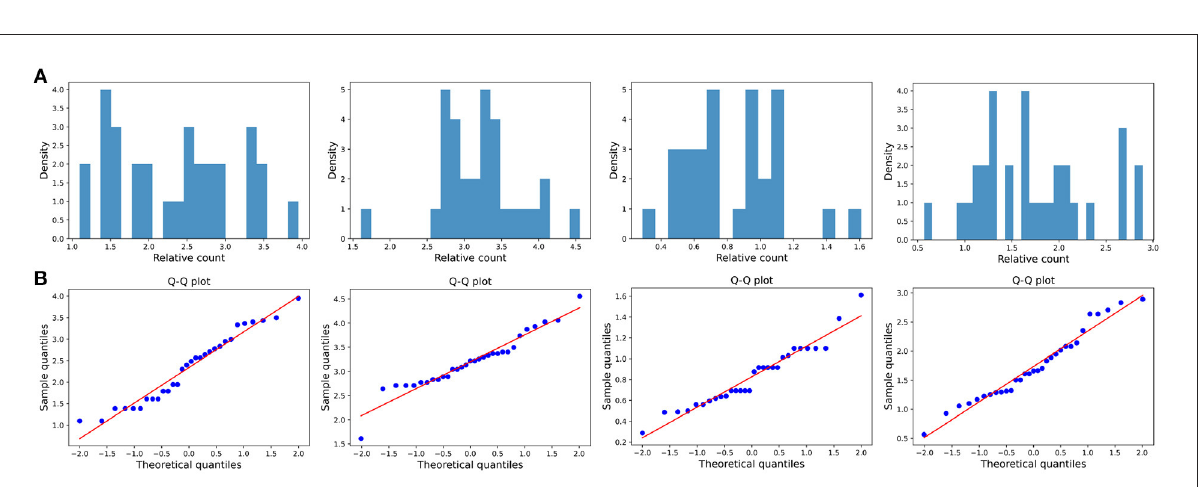
FIGURE7 Large impact type. (A) The ratio density of cumulative mentions for the four time intervals. The time interval setting is same as Transient type. (B) The Q-Q plots of the distribution of cumulative mentions relative to the normal